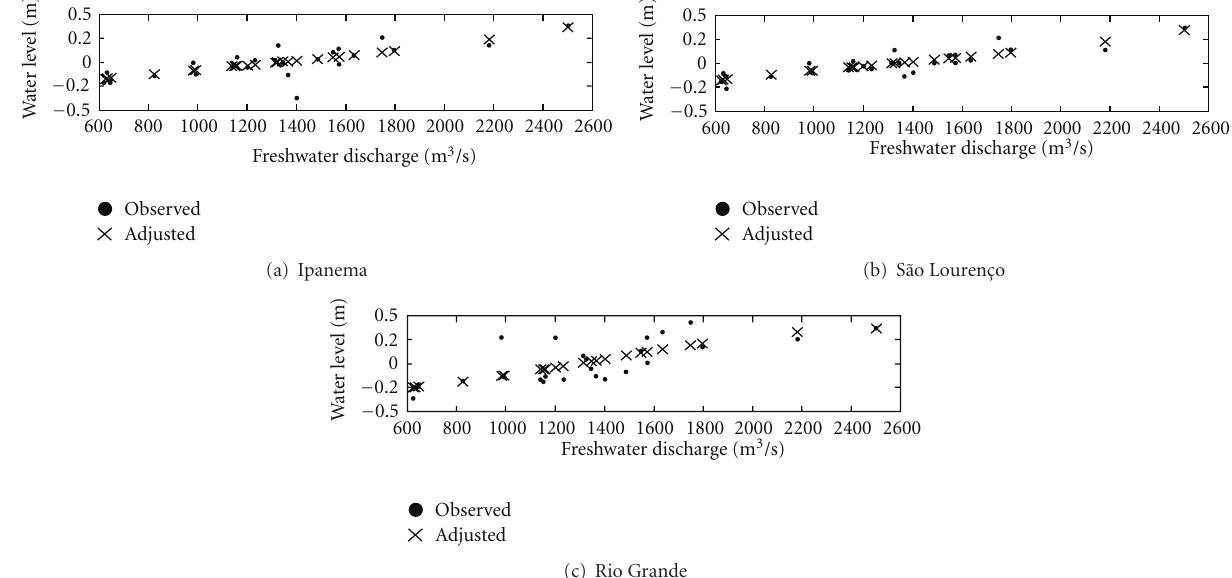
Figure 3: Dispersion diagram between freshwater discharge and water levels at Ipanema (a), S˜ao Lourenc¸o (b), and Rio Grande (c) between 1985 and 2010. The best third order adjustment is represented by the crosses in the figures.